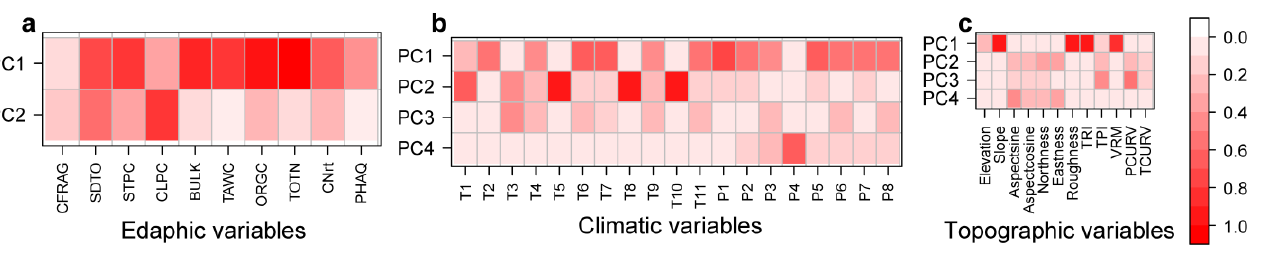
Figure A4. Contributions of each variable to the most n important principal components (PCs) of edaphic variables (a), climatic variables (b), and topographic variables (c). n is the number of PCs retained based on Kaiser’s criterion.